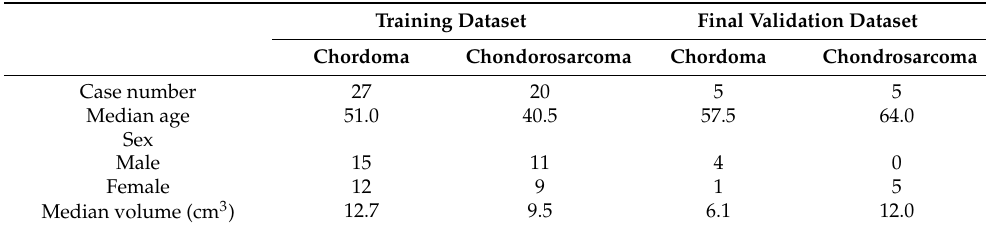
Table 1. Patient and tumor